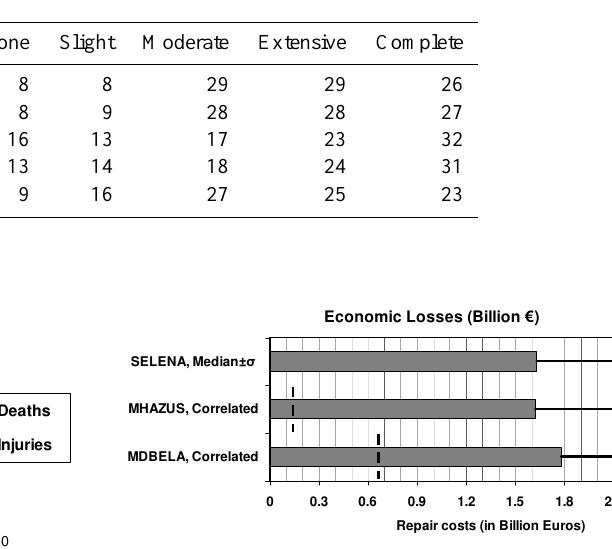
Table 5. Building damage % in HAZUS-based classes for the 3 ELE packages.